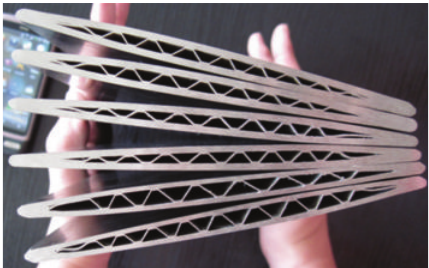
Figure 3: The titanium Warren girder hollow panel used as test